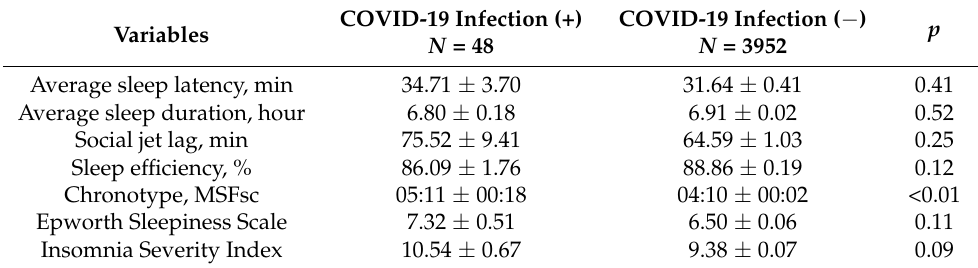
Table 3. Sleep and circadian rhythm according to COVID-19 infection history.